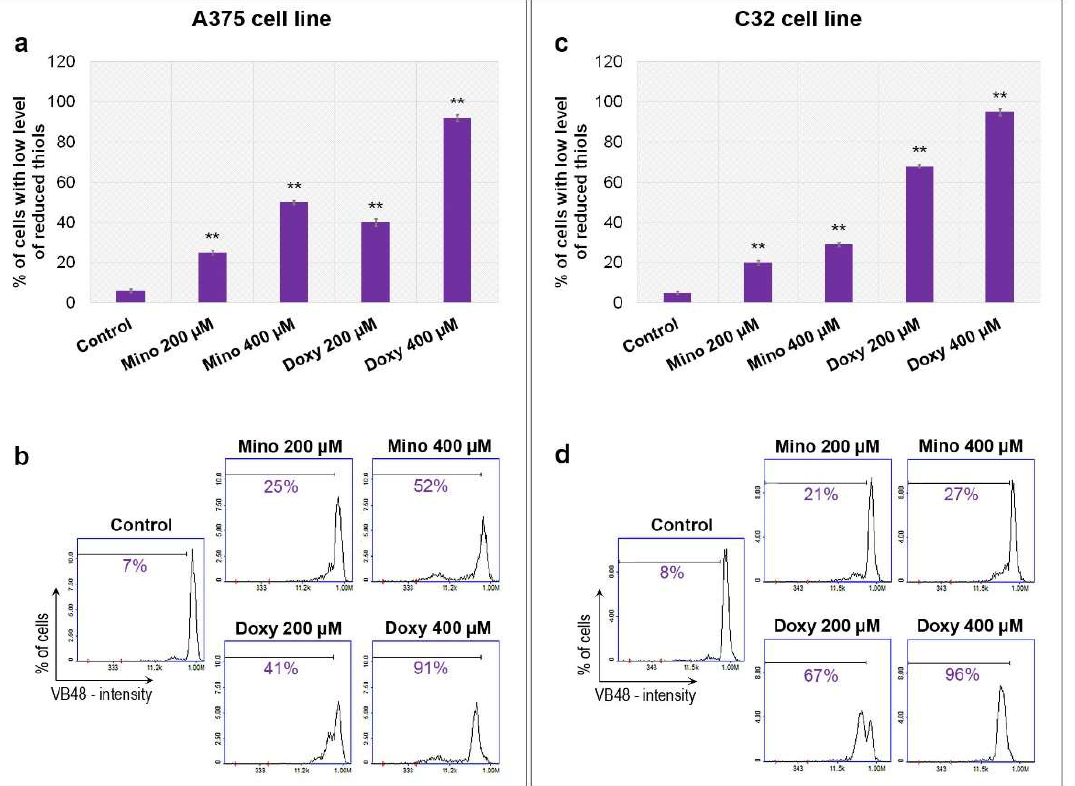
Figure 4. Analysis of intracellular thiols after the treatment of melanoma cells with minocycline and doxycycline. Bar graphs present the results for A375 ( a ) and C32 ( c ) cell lines. Representative histograms ( b , d ) display corresponding tested populations. Marked percentages signify cells with a low level of reduced thiols. ** p < 0.005 vs. control.